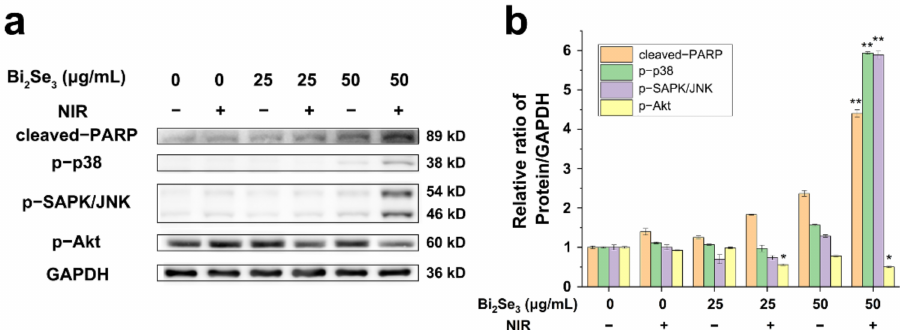
Figure 5. Effects of Bi 2 Se 3 on intracellular stress-related and survival-associated signaling pathways. ( a ) The expressions of cleaved-PARP, phosphorylated p38 (p-p38), phosphorylated SAPK/JNK (p- SAPK/JNK) and phosphorylated Akt (p-Akt) in A549 cells under different conditions by western blot analysis. GAPDH serves as a loading protein. The representative data of three independent experiments are shown here; ( b ) The bands of these proteins of interest proteins from the results of three independent experiments were quantified using ImageJ. * p < 0.05, ** p < 0.01 versus control group. The data presented are representative of three independent